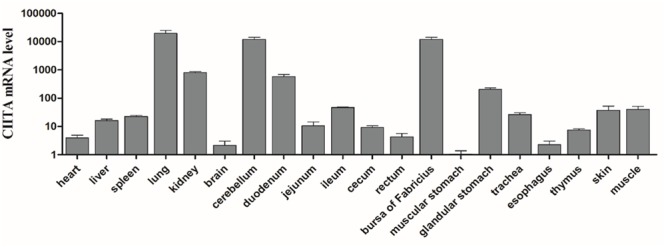
Tissue distributions of CIITA in the healthy Cherry Valley duck. The relative mRNA levels were normalized to the expression of the β-actin gene from various tissues. The data were normalized to the muscular stomach, and error bars indicated the SD.